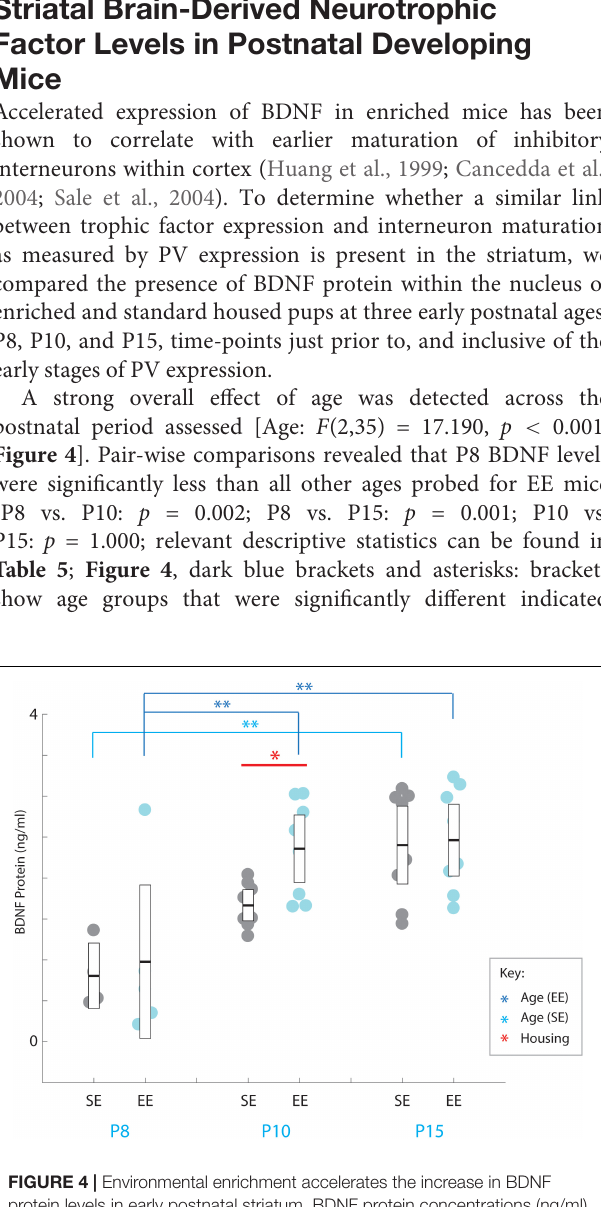
FIGURE 4 | Environmental enrichment accelerates the increase in BDNF protein levels in early postnatal striatum. BDNF protein concentrations (ng/ml) for individual standard (SE; grey), and enriched (EE; cyan) housed mice at ages P8 ( n = 5), P10 ( n = 8), and P15 ( n = 8). Dark blue brackets and asterisks (EE Samples): EE samples exhibited significantly higher concentrations of BDNF at P10 and P15 compared to P8 levels (P10: p = 0.002; P15: p = 0.001). Light blue bracket and asterisks (SE Samples): SE material only yielded differences between P8 and P15 ( p = 0.001). Red bar and asterisks (Housing): Pairwise comparisons revealed a significantly greater level of BDNF protein present in the striatum of EE vs. SE mice at P10 ( p = 0.036; black asterisk). Means (solid bar) and standard errors of the mean (s.e.m.; extent of white boxes) are depicted. ∗ p < 0.05; ∗∗ p < 0.01.